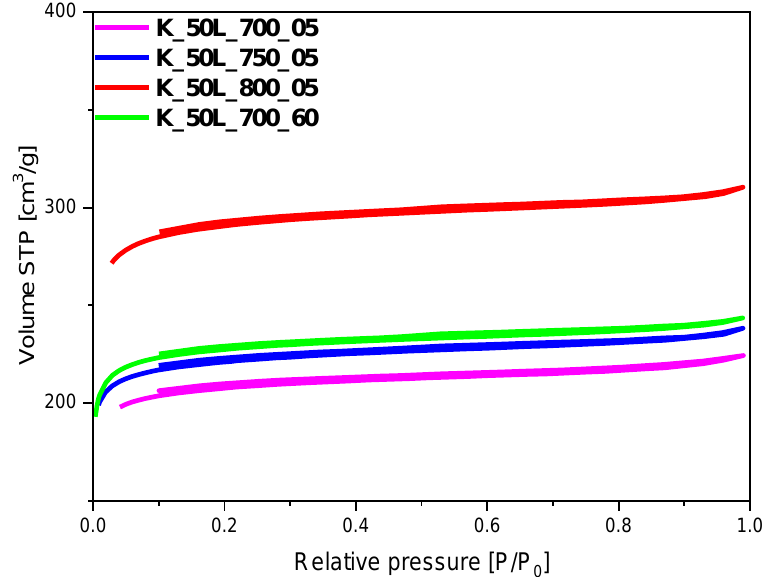
Figure 4. Nitrogen adsorption-desorption isotherms of the samples activated at different temperatures and with different dwell times.